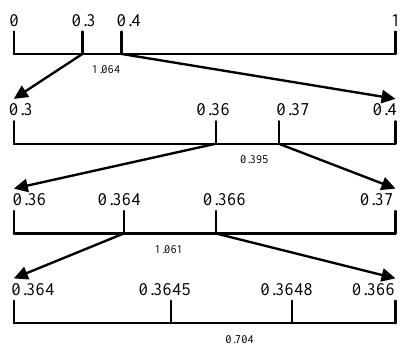
interval of [0, 1], and the output are converted to floating-point type. This entropy coding is very efficient. The output probability of the model is context-adaptive, the prediction probability is closer to the source probability, the total entropy obtained is smaller, the value range of the final coding interval is wider, and the compression effect will be better than static arithmetic coding.